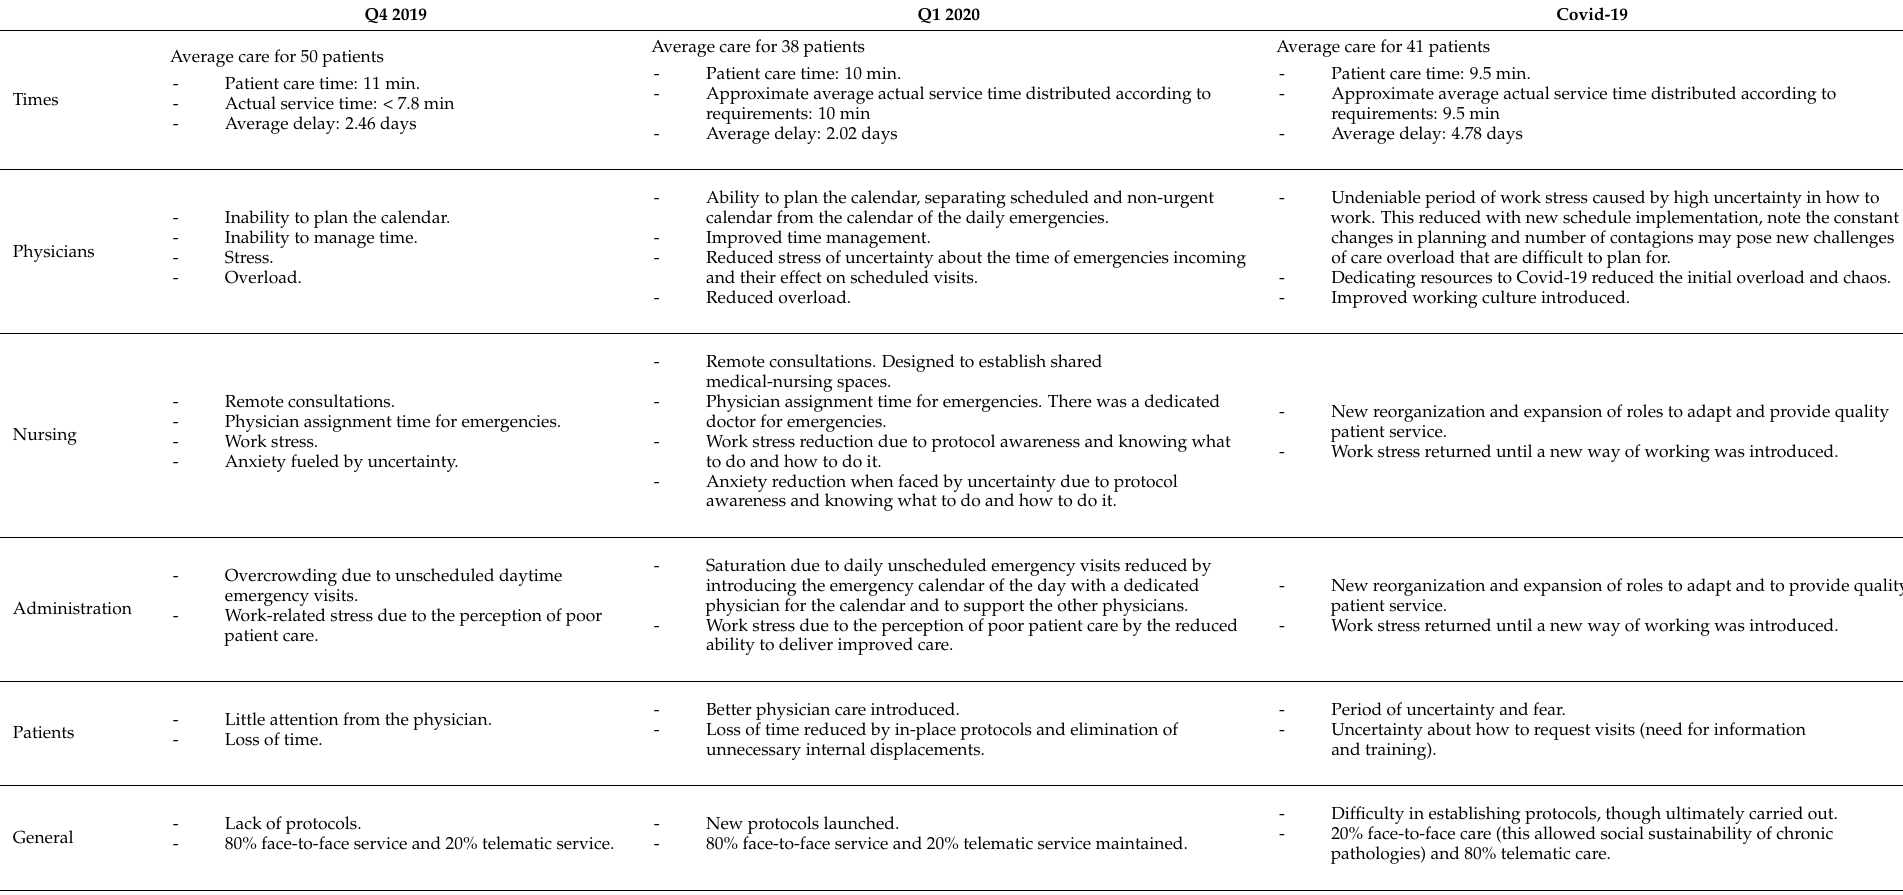
Table 11. Summary of comparative situations